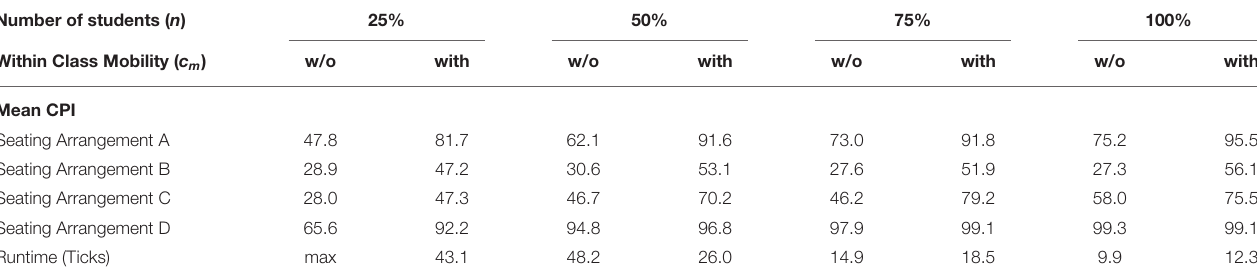
TABLE 6 | List of CPI and the number of runtimes for the four seating arrangements A, B, C, and D with the transmission rate of 0.10, the number of initially infected individuals at 0.10, varying number of students and within-class mobility. Number of students ( n ) 25% 50% 75% 100% Within Class Mobility ( c m ) w/o with w/o with w/o with w/o with